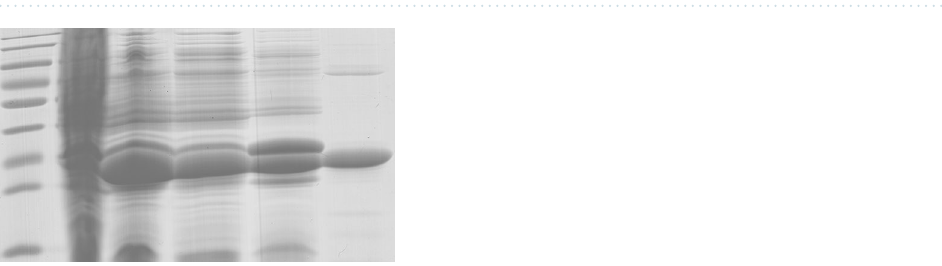
Figure 3. Relative transcript levels of MvitOBP3 gene in different tissues of M. vitrata .